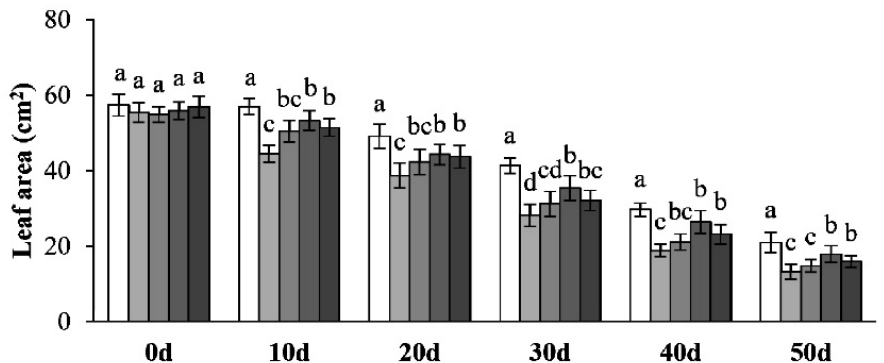
Figure 4. Effect of exogenous spermidine on SPAD value, P n and leaf area of maize leaves at post- anthesis stage under drought stress. Different letters within the same column indicate significant difference at 5% level.